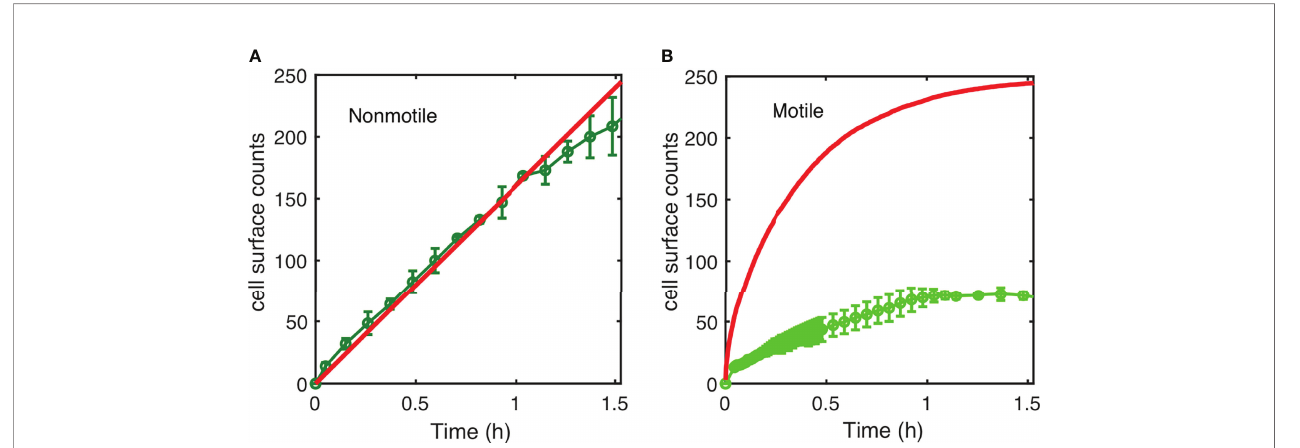
FIGURE 4 | Simulated kinetics of settling and diffusion towards the surface. (A) The number of nonmotile cells reaching the surface as a function of time in a 1-mm high channel was calculated according to settling using the diffusion coef fi cient “ D=10 µm 2 /s ” and “ D=200 µm 2 /s ” cell size a=1 µm; g=10 m/s 2 ; and cell-medium mass density contrast D r = 80 kg / m 3 (red line) and compared to the experimental counts (same as in Figure 3 ). (B) Numerical simulation of surface access kinetics of motile cells (red line) represented with the corresponding experimental counts (as in Figure 3